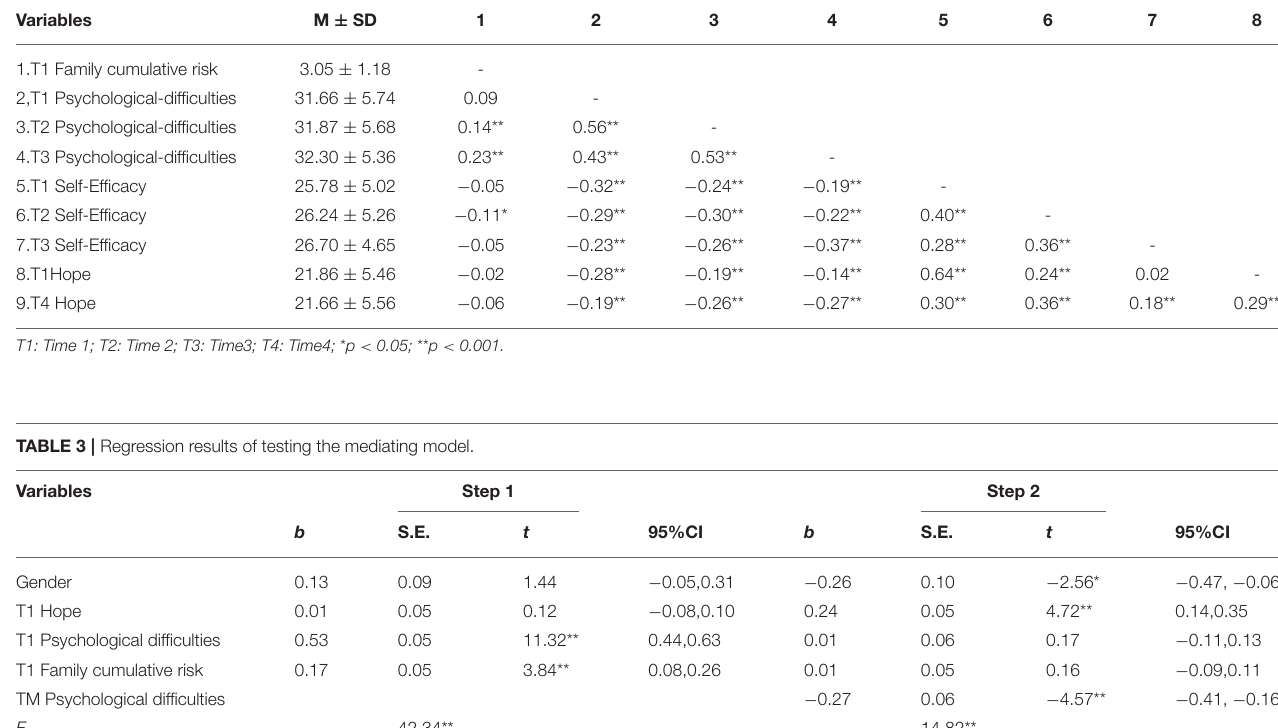
TABLE 2 | Descriptive statistics and correlation analyses. Variables